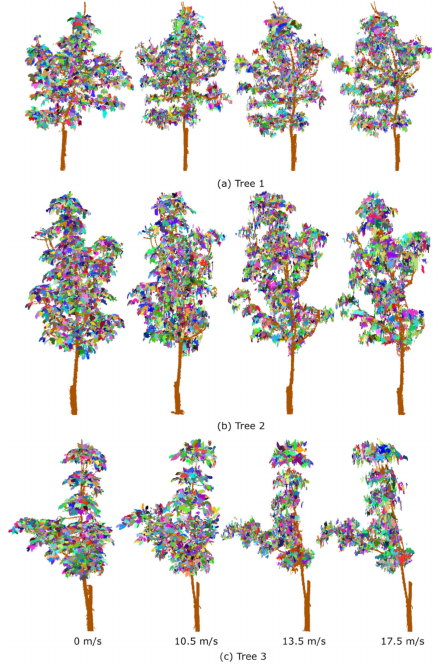
Figure 5. Leaf distribution for each rubber tree under four wind speeds obtained using an individual leaf segmentation algorithm, where brown represents the trunk and branches, and the extracted individual leaves are highlighted in different colours. ( a – c ) correspond to Tree 1, Tree 2, and Tree 3, respectively. Each column of the figure from left to right represents the individual leaf segmentation results of the same tree under forced draft fan-emitted wind speeds of 0 m/s, 10.5 m/s, 13.5 m/s, and 17.5 m/s, respectively.